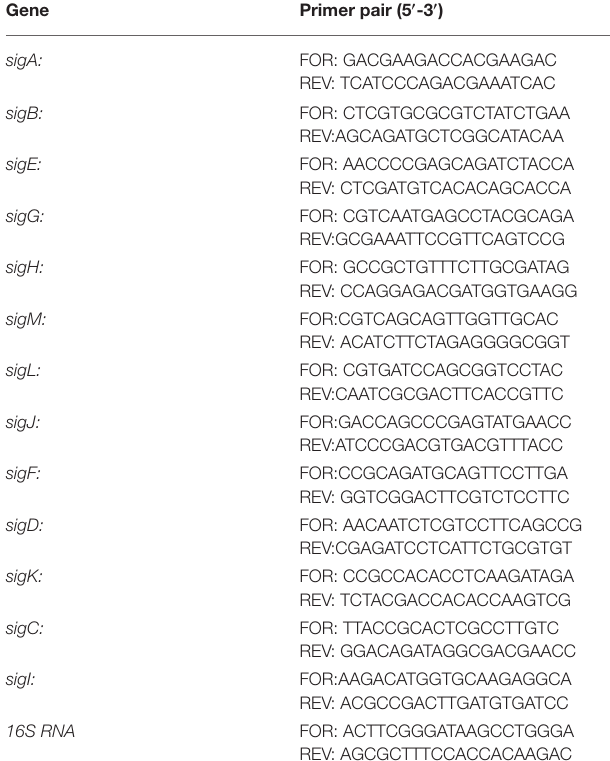
TABLE 1 | Primers used for qPCR